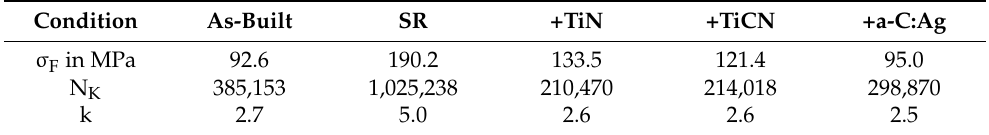
Table 3. Overview of the fatigue properties of the as-built, SR, TiN-coated, TiCN-coated, and a-C:Ag- coated conditions; fatigue strength, σ F , cycles at the knee point, N K of the failure probability curves, P F50% , Wöhler line slope, k. Condition